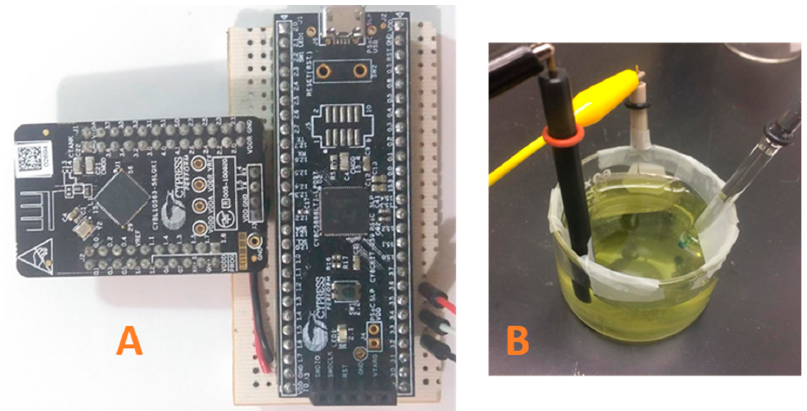
Figure 5. ( A ) Prototype of the EPS. ( B ) Electrochemical cell (height = 35 mm, diameter = 60 mm), solution volume of 50 mL of K ₃ [Fe(CN) ₆ ] and KCl.